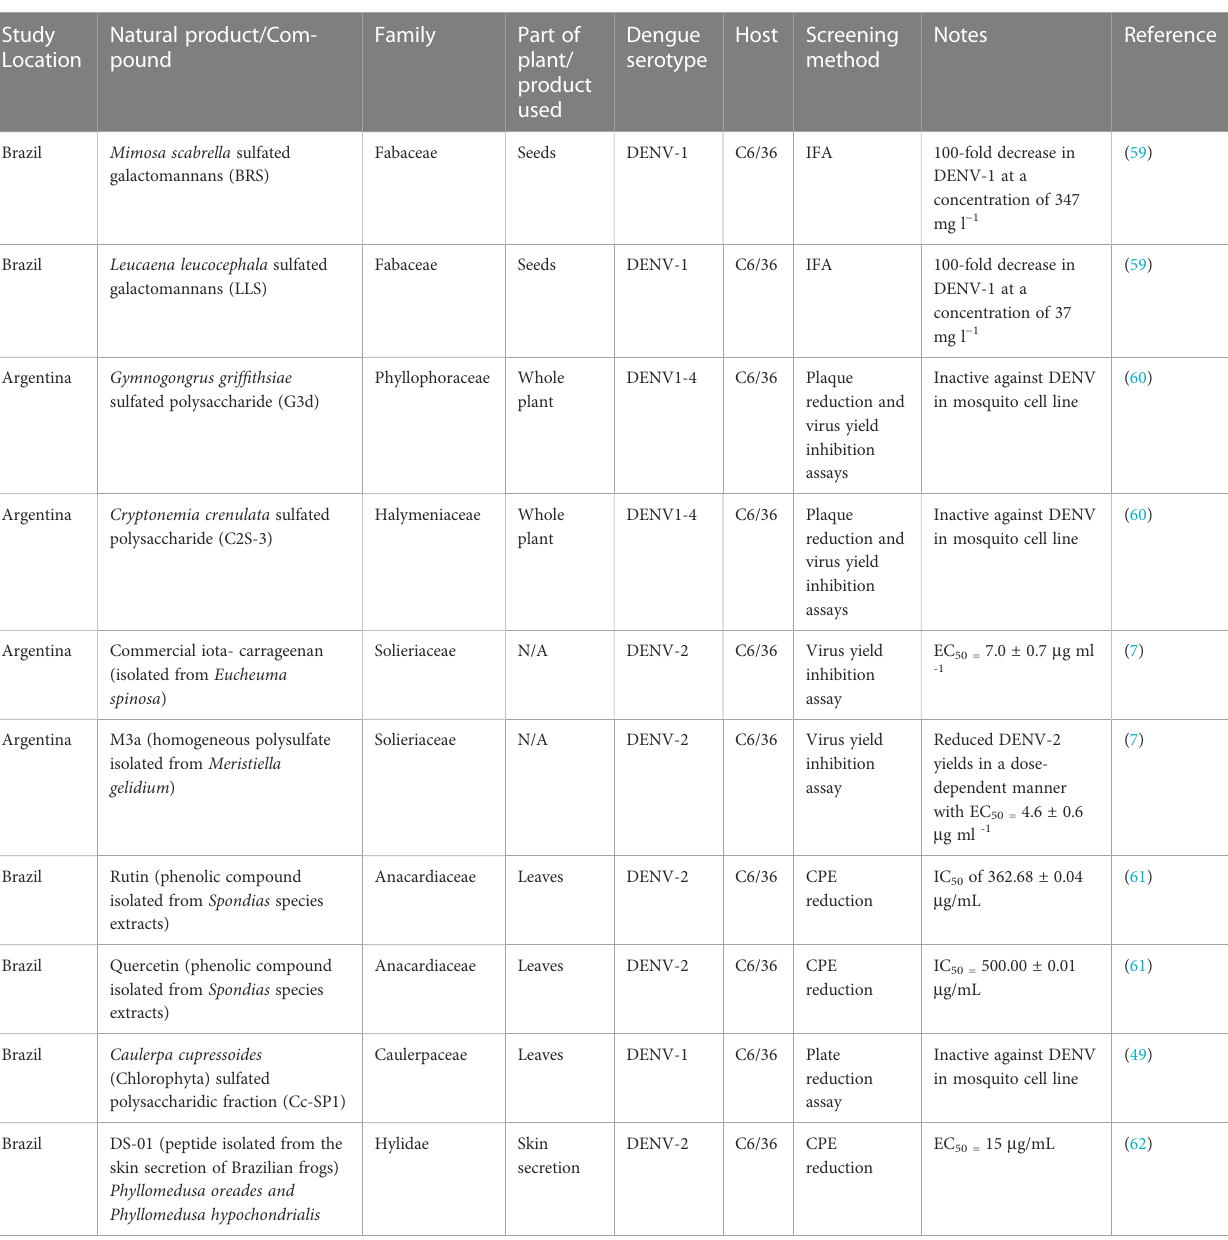
TABLE 2 Antiviral potential of natural products against dengue virus in mosquito cell lines. Study